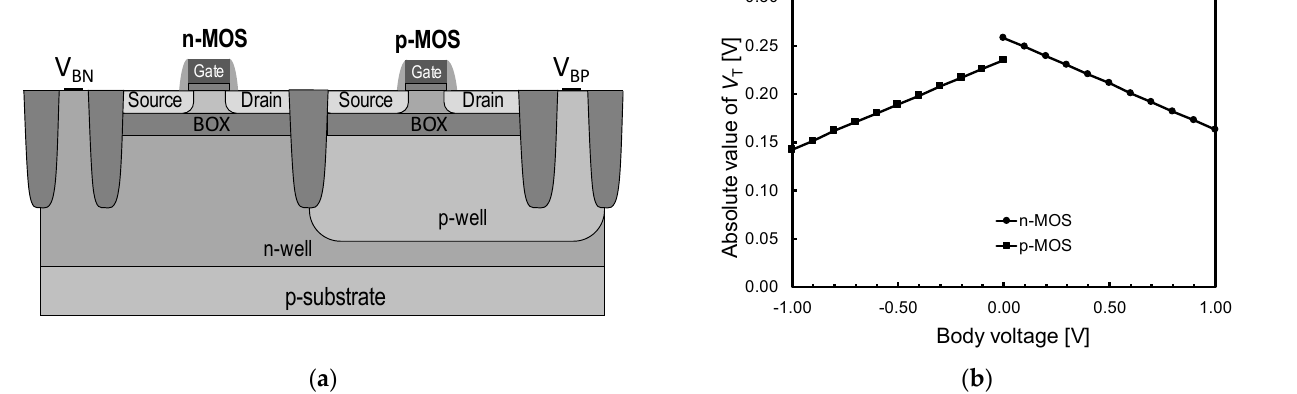
Figure 4. The 28-nm FD-SOI CMOS technology: ( a ) simplified cross-section of LVT flipped-well transistors, ( b ) V T variation with respect to the body voltage for the LVT flipped-well devices. Reprinted with permission from ref. [25]. Copyright 2019, IEEE.